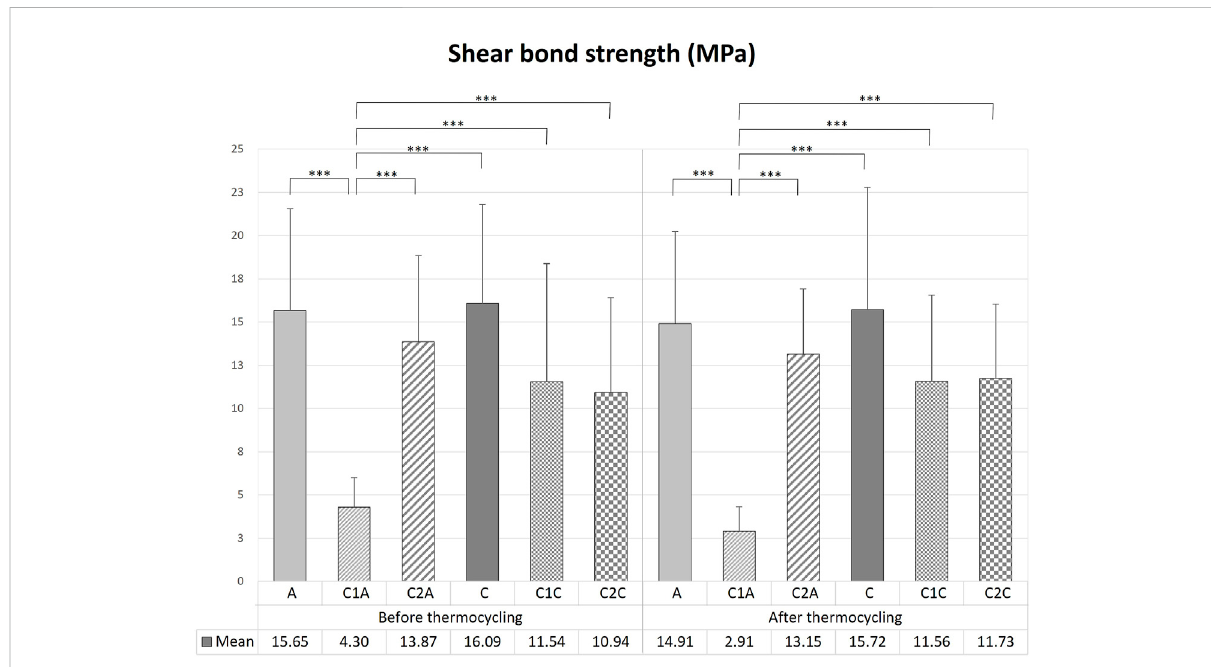
FIGURE 7 Comparison of the shear bond strength of bracket debonding before and after 10,000 thermocycles. This fi gure presents the data in Table 1. Error bars represent the standard deviation of the mean. *** indicates signi fi cance at p < 0.001.